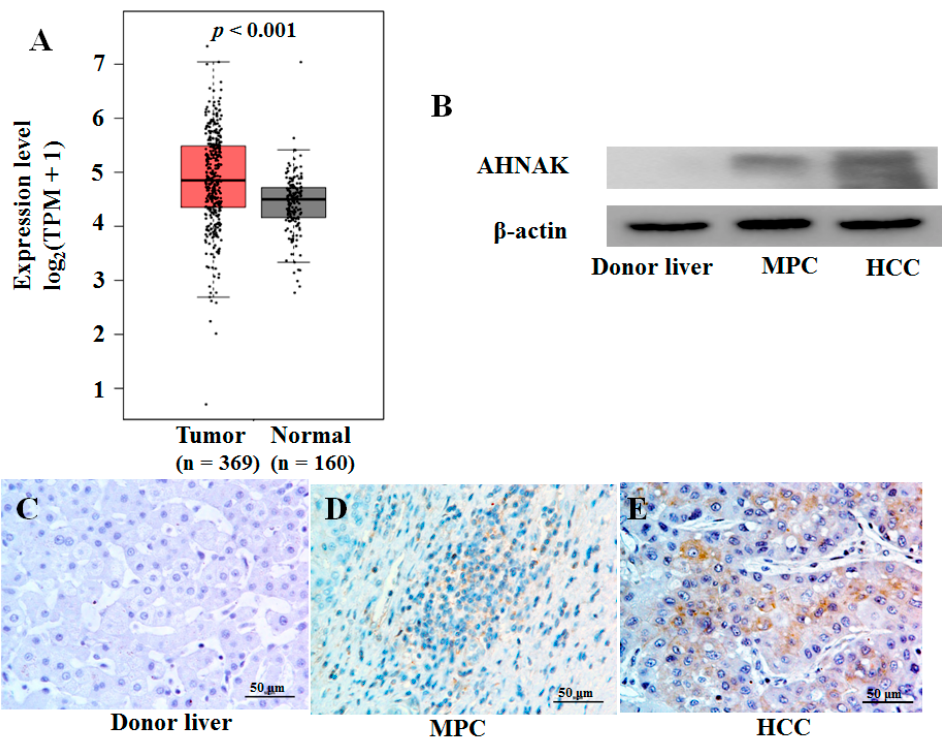
Figure 2. AHNAK was overexpressed in HCC tissues: ( A ) Up-regulated mRNA expression of AHNAK in HCC tissues samples from TCGA database (369 tumor and 50 normal samples) and GTEx database (110 normal samples); p < 0.001. ( B ) Results of Western blotting analysis of protein expression of AHNAK in donor liver, tumor and MPC tissues. Results of immunohistochemical analysis of protein expression of AHNAK in donor liver ( C ), MPC tissues ( D ) and HCC tissues ( E ). Scale bar, 50 μ m. TCGA, The Cancer Genome Atlas; GTEx, Genotype-Tissue Expression; MPC, matched paracancerous.